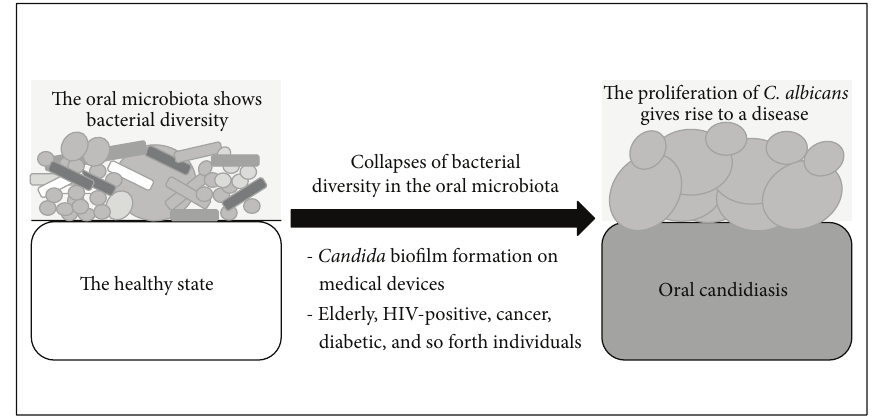
Figure 2: Illustration of the shift in the commensal microbiota in the healthy state relative to the disease state (see Section 4).